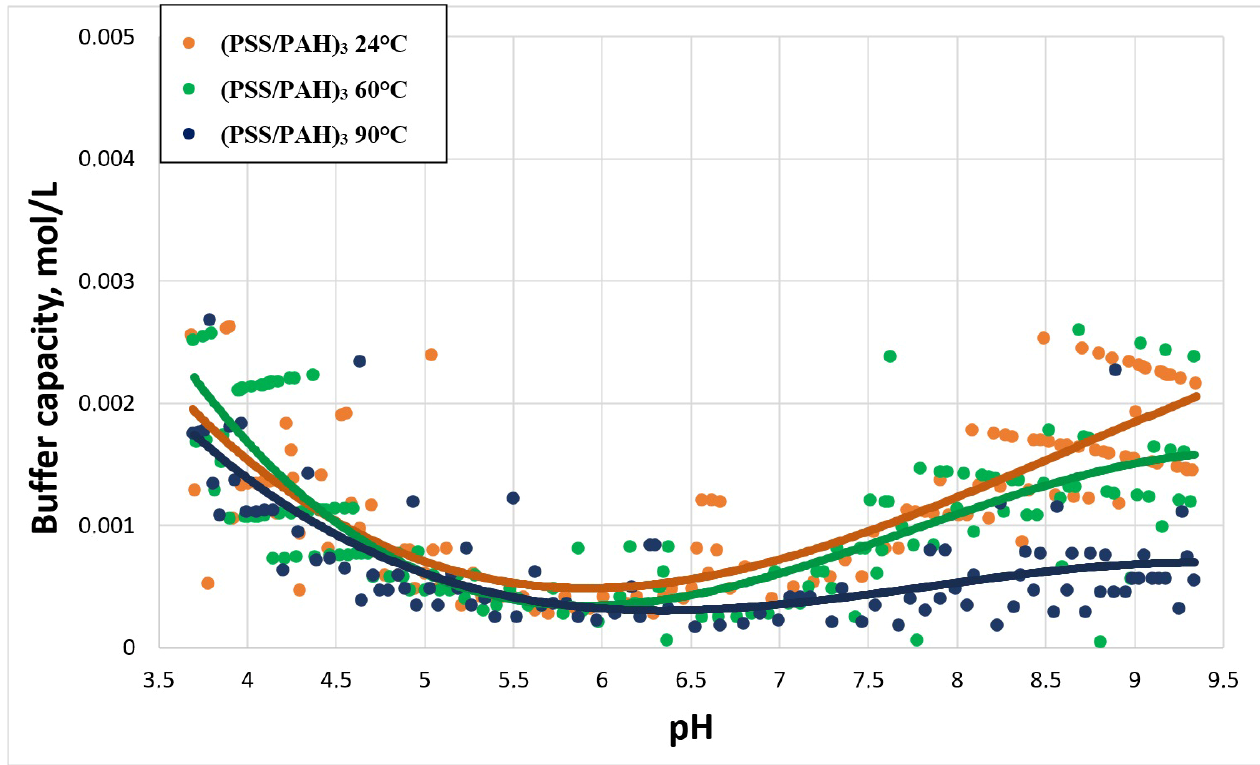
Figure 3. Buffer capacity of PMC composition (PSS/PAH) 3 at different pH after hour incubation at the 24 ◦ C, 60 ◦ C and 90 ◦